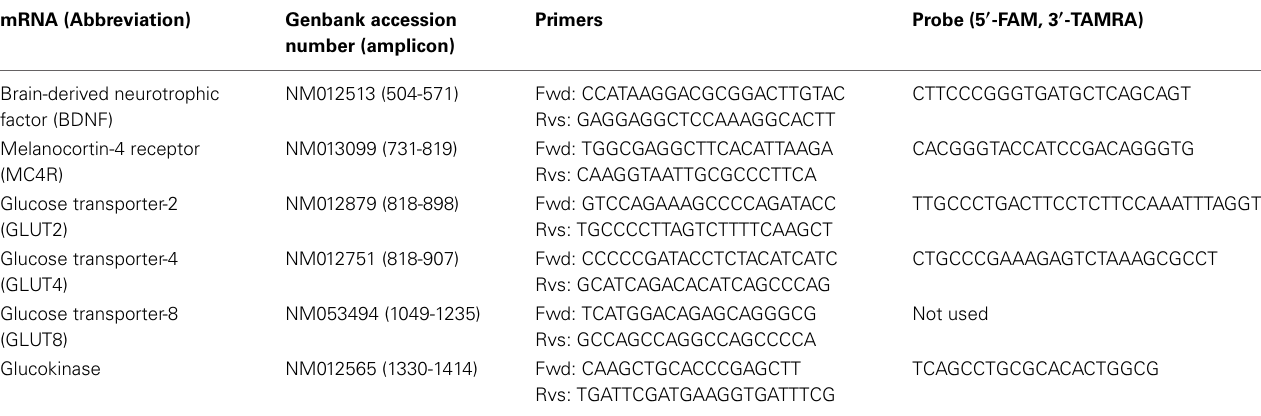
FIGURE A1 | Glycemic profiles of GK rats. (A) The blood glucose level under fed conditions in Wistar and GK rats at the age of 11 and 26 weeks. The blood glucose level in GK rats was significantly higher than that in Wistar rats at both 11 and 26 weeks ( ∗ p < 0 . 05 and ∗∗ p < 0 . 01, respectively, Student’s t -test). The difference was greater